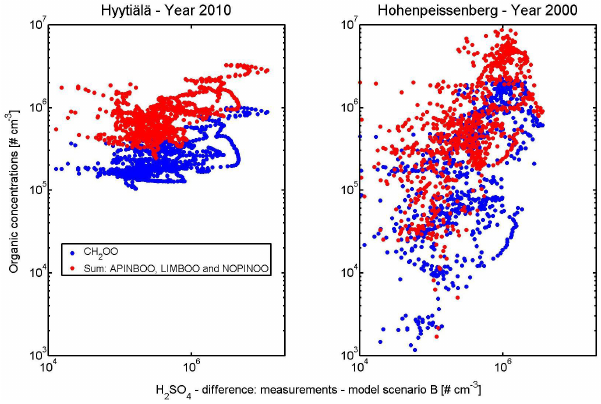
Fig. 4. Scatter plot of organic vapours against the missing sulfuric acid concentrations for the selected periods at both